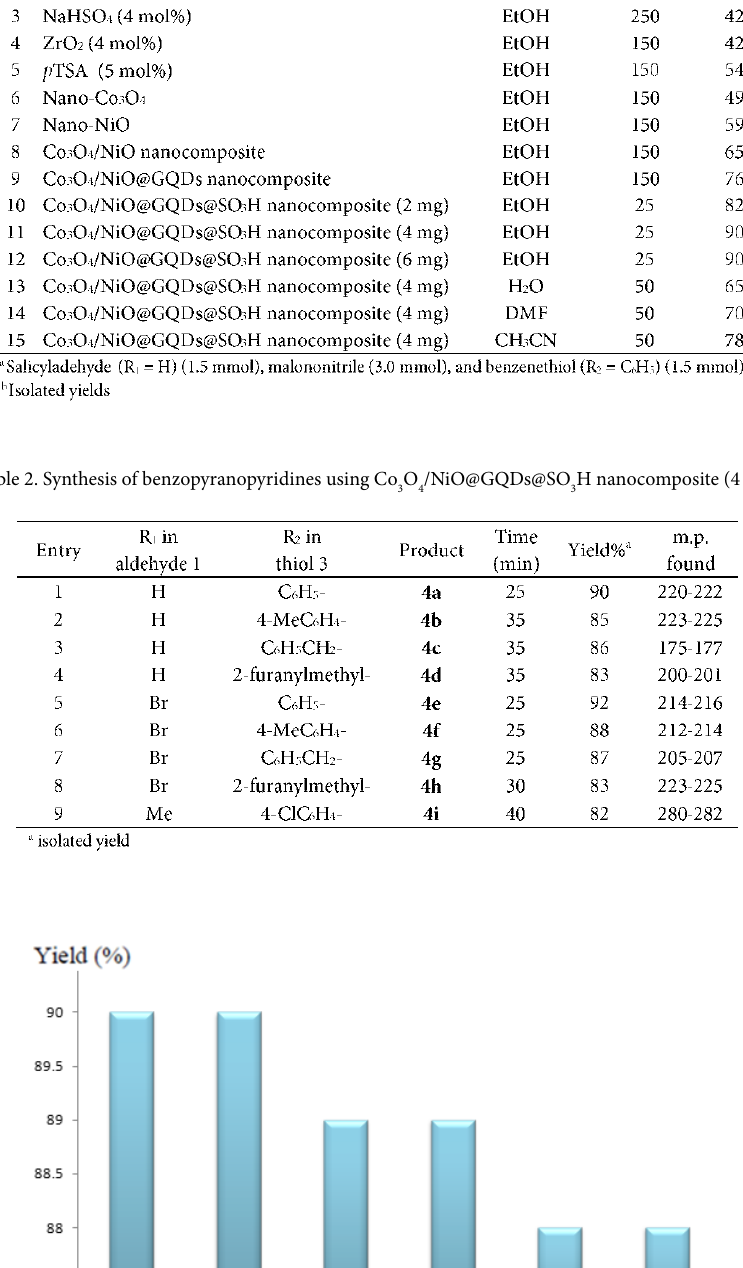
Fig. 9. Recycling of Co 3 O 4 /NiO@GQDs @SO 3 H nanocomposite as a catalyst for the model reaction